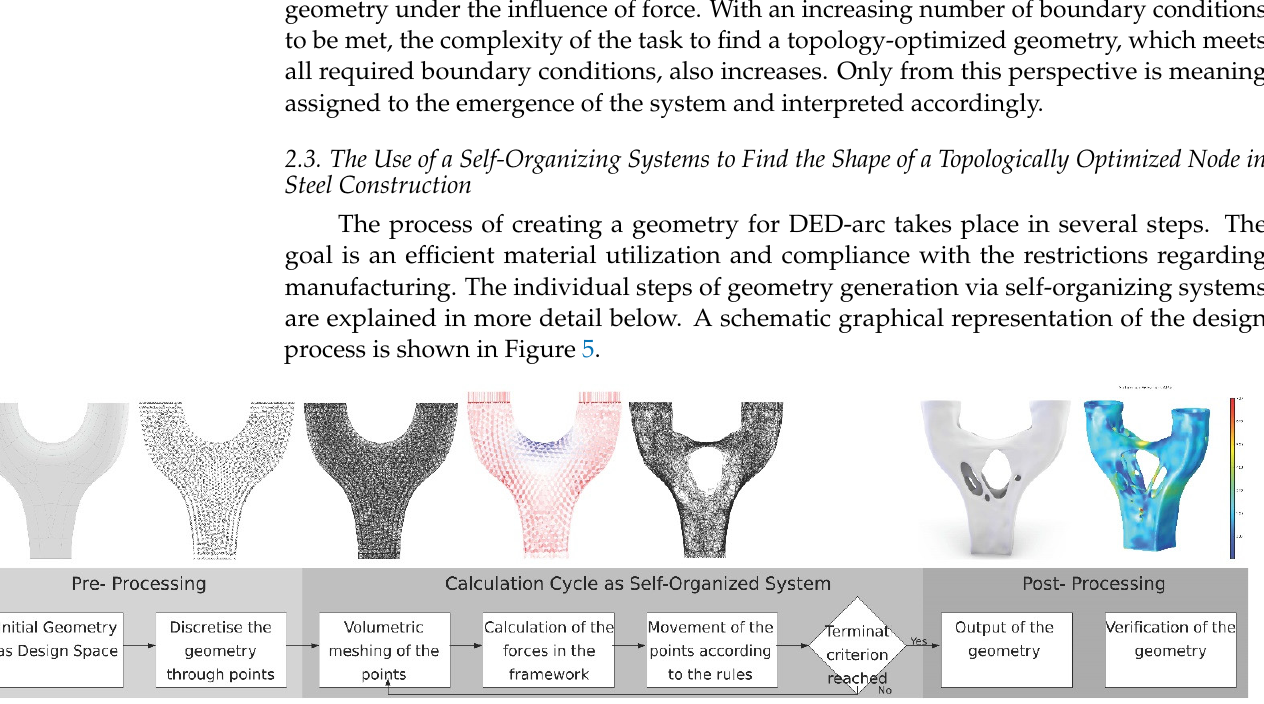
Figure 5. Presentation of the basic process of form finding. From left: Initial design as design space; point representation of the geometry; volumetric mesh of the point representation; calculation of the bar forces by means of FEA; volumetric mesh as result of the calculation cycle; output geometry as volumetric model; verified geometry on FEA model.